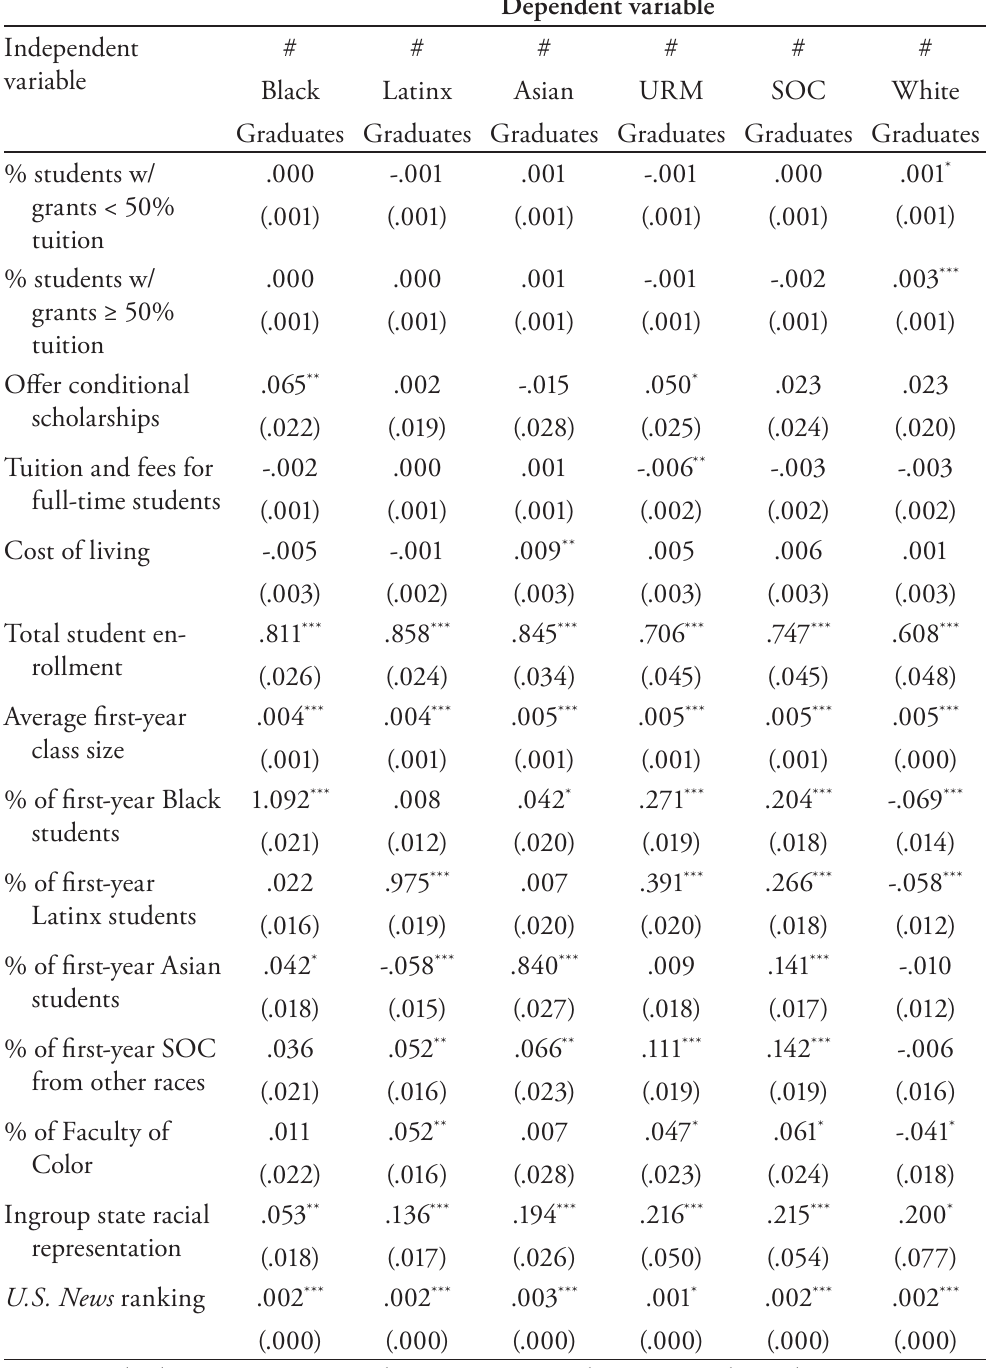
Table 1. Unstandardized Coefficients for Random Effects Analyses